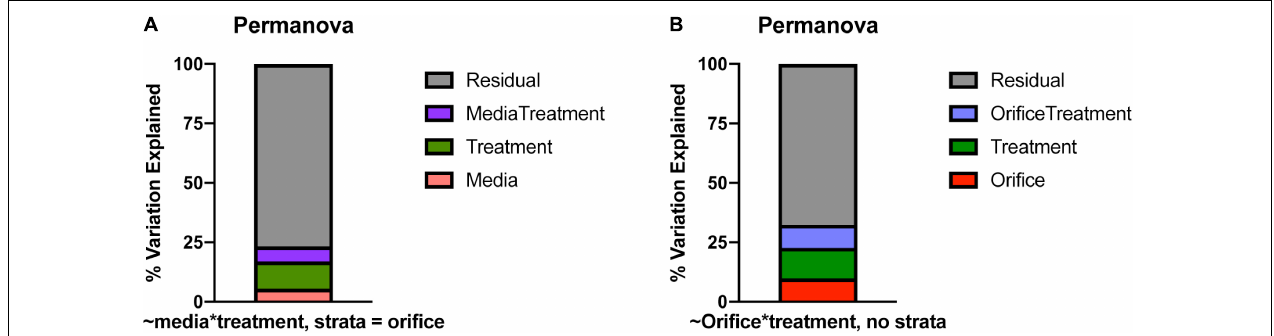
FIGURE 5 | Percent of variation described by permanova models based on (A) media and treatment with orifice as a stratum, (B) orifice and treatment. Largely, the differences in community structure during cultivation could not be explained by media, orifice, or treatment alone. In all graphs, residual variation (in gray), is the proportion of variance not explained by the